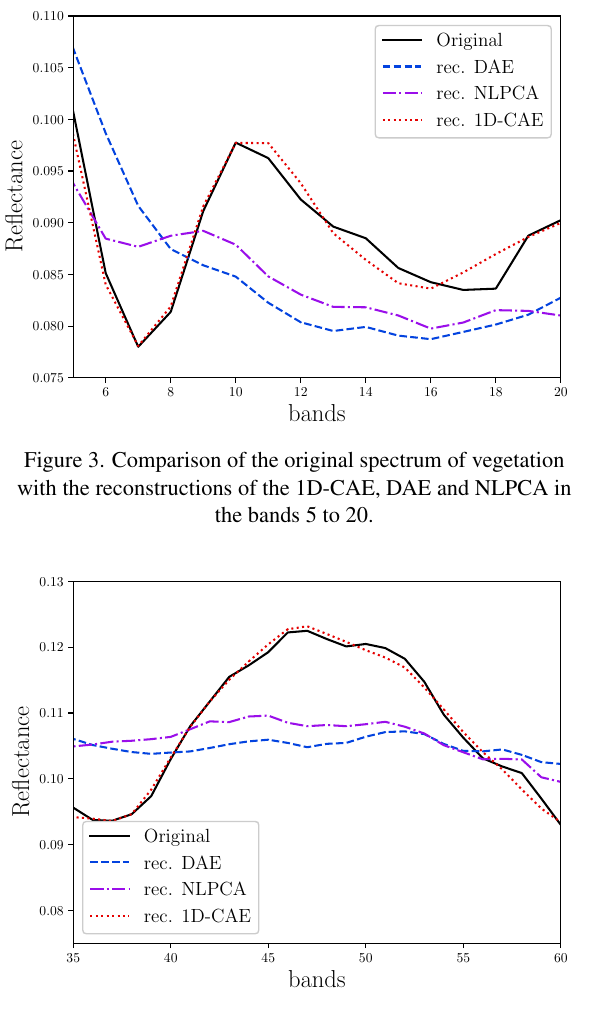
Figure 4. Comparison of the original spectrum of vegetation with the reconstructions of the 1D-CAE, DAE and NLPCA in the bands 35 to 60.